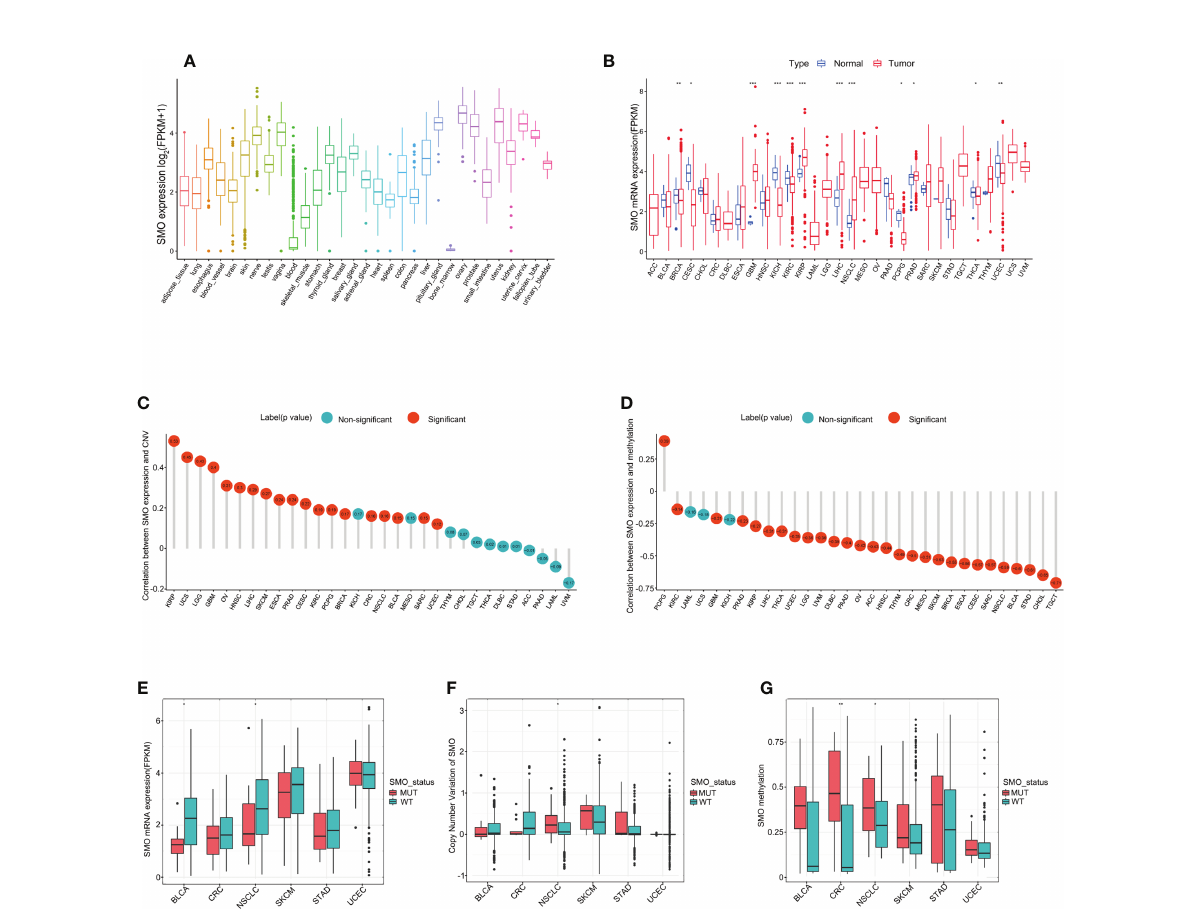
FIGURE 4 SMO expression pro fi les in normal human tissues and cancer tissues. (A) SMO expression pro fi les in normal human tissues in the GTEx database. (B) Comparison of SMO expression between tumor and normal samples in The Cancer Genome Atlas (TCGA) cohort. (C, D) Correlations between SMO expression and copy number variant (CNV) (C) and between SMO expression and promoter methylation (D) in the TCGA cohort. (E, F) Comparisons of the SMO expression (E) and SMO CNV (F) between the SMO mutant (SMO_MUT) and SMO wild-type (SMO_WT) tumors in different cancer types in the TCGA cohort (Mann – Whitney U test). (G) Comparison of SMO promoter methylation between the SMO_MUT and SMO_WT tumors in different cancer types in the TCGA cohort (Mann – Whitney U test). * p < 0.05, ** p < 0.01, *** p <